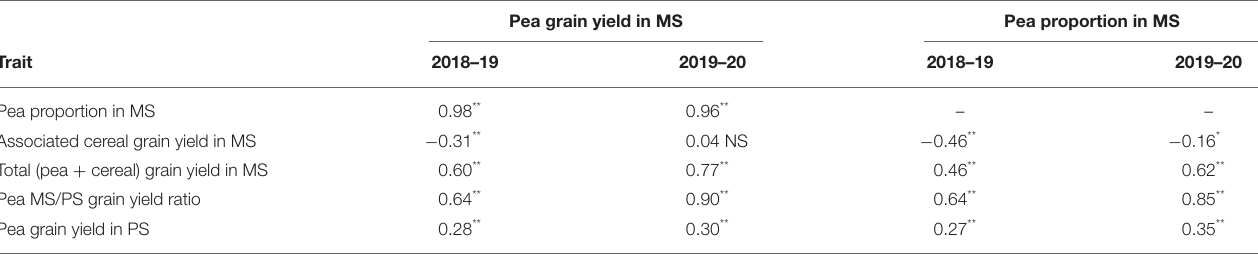
TABLE 2 | Phenotypic correlation of pea grain yield or pea proportion in mixed stand with cereals (MS) with pea or cereal yield traits in MS or pea yield in pure stand (PS), for 144 pea inbred lines grown in two cropping years. Pea grain yield in